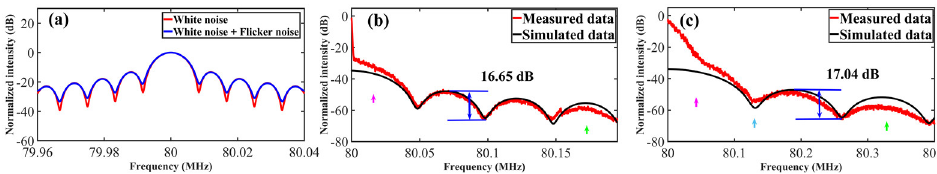
Figure 6. ( a ) The simulated self-heterodyne spectrum with and without the flicker noise. The self- heterodyne spectrum and simulated curve of ( b ) the SIL laser with delay fiber of 4.168 km and ( c ) the BEFL with delay fiber of 14.3 km.